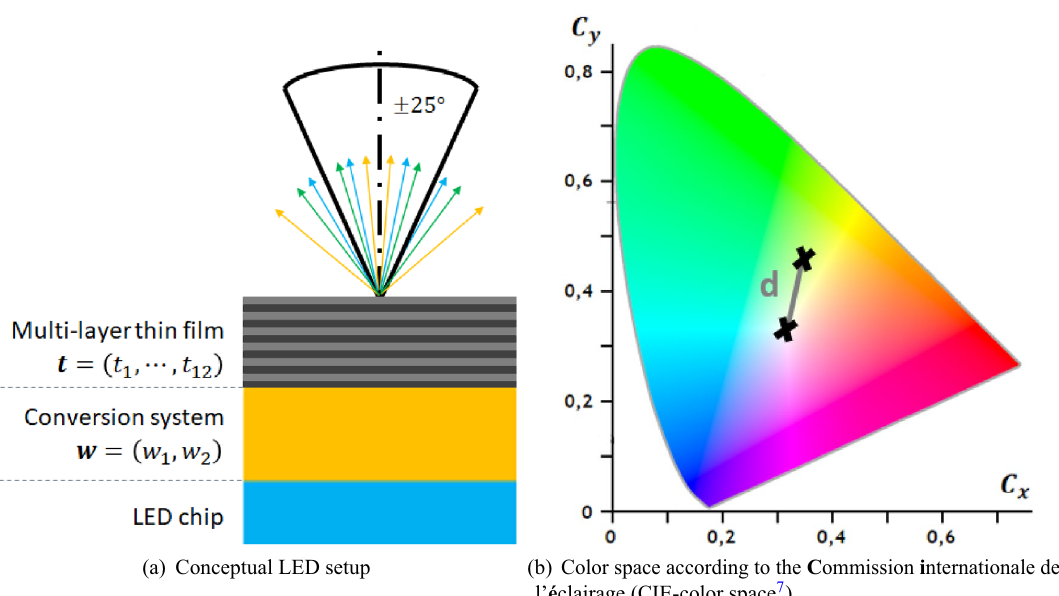
Figure 1. An LED ( a ) consists of a chip, a conversion system and a multi-layer thin film that features ten layers. The latter focuses the emitted light spectrum into a ± 25 ◦ -angle cone. The spectrum is composited of light rays (arrows) of different wavelengths. Such a spectrum is analytically associated 4,5 with a point c = color space ( b ). The color point, roughly speaking, encodes the perceived color of a spectrum. The Euclidean distance between two color points (crosses) is denoted as the color point deviation d . In this work, one of these points is the so-called white (target) color point